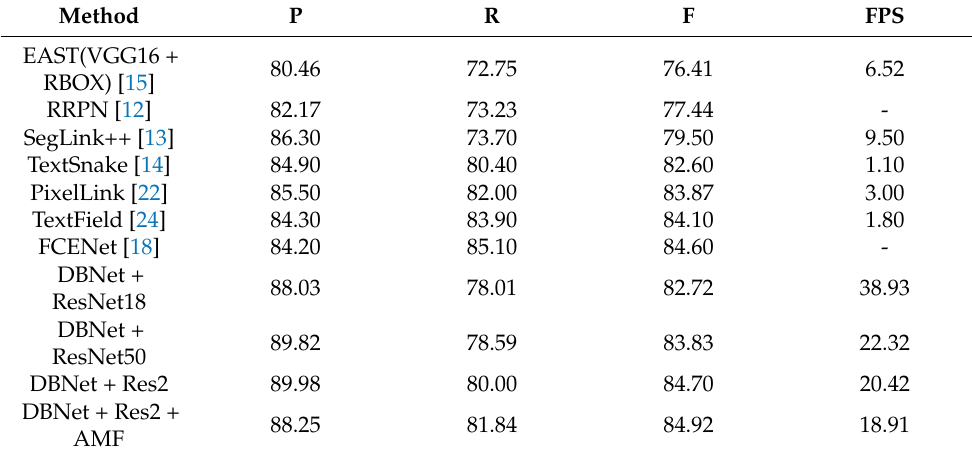
Table 3. The results of text detection on ICDAR2015